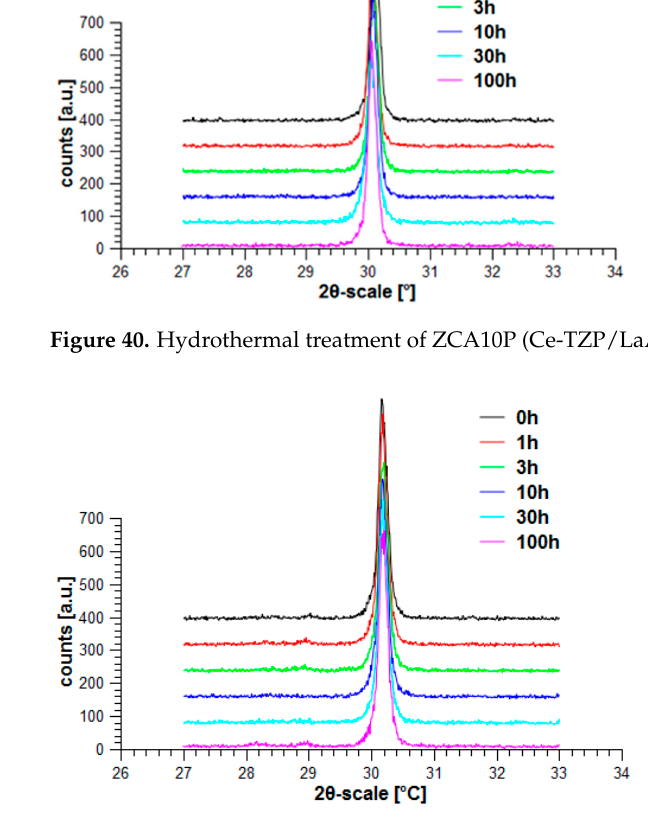
Figure 41. Hydrothermal treatment of ZA05P (Y-Ce-TZP/Al 2 O 3 /LaAl 11 O 18 ).